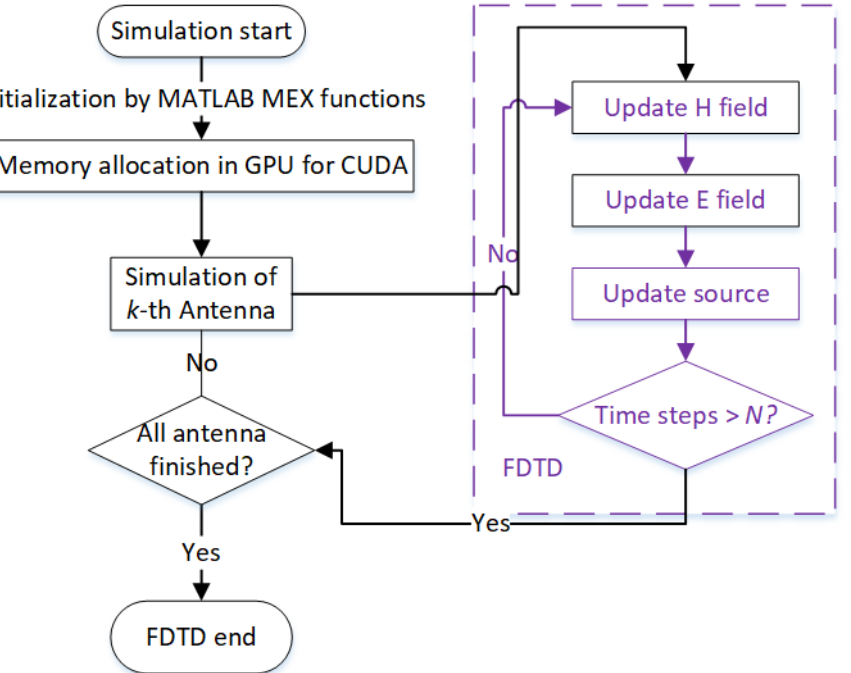
Figure 1. Flowchart of the GPU-based FDTD